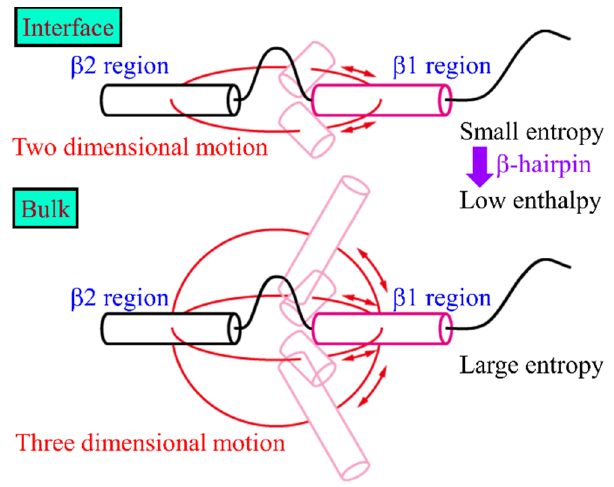
Figure 7. Schematic illustration of the A β 40 peptide at the interface and in the bulk water. Reprinted with permission from Reference [25]. Copyright 2019 American Chemical Society.